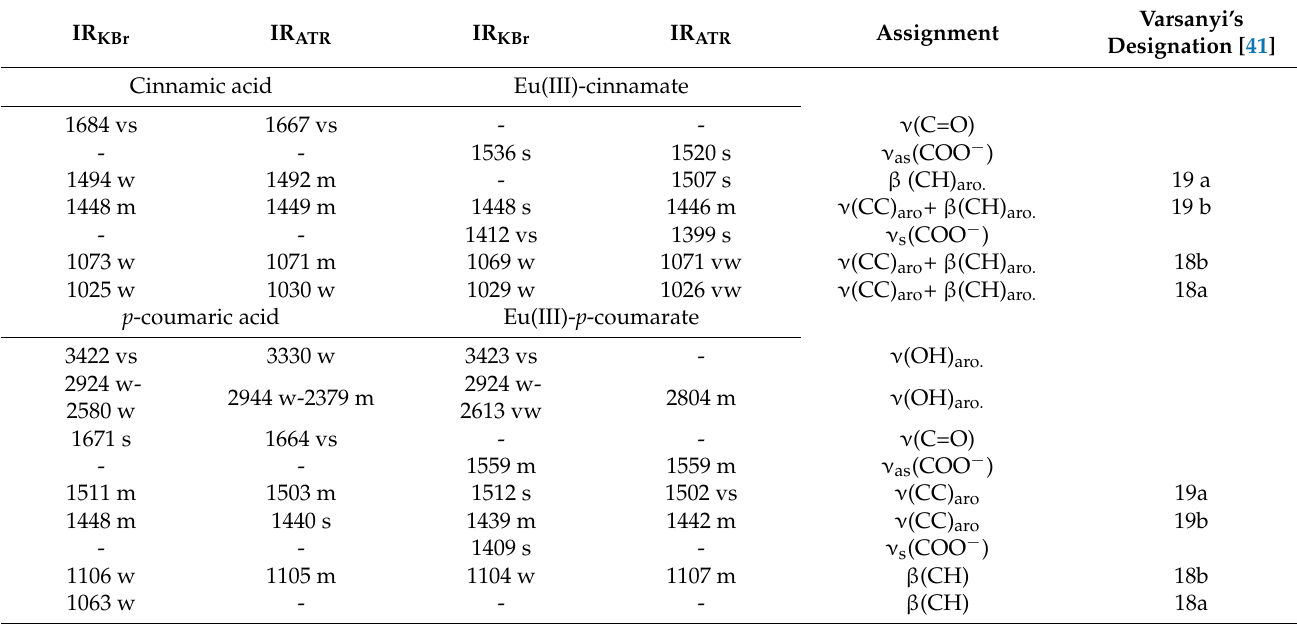
Table 2. The wavenumbers (cm − 1 ), intensities and assignments of bands observed in the experimental FT-IR (KBr and ATR) spectra of cinnamic acid, Eu(III)-cinnamate and p -coumaric acid, and Eu(III)- p